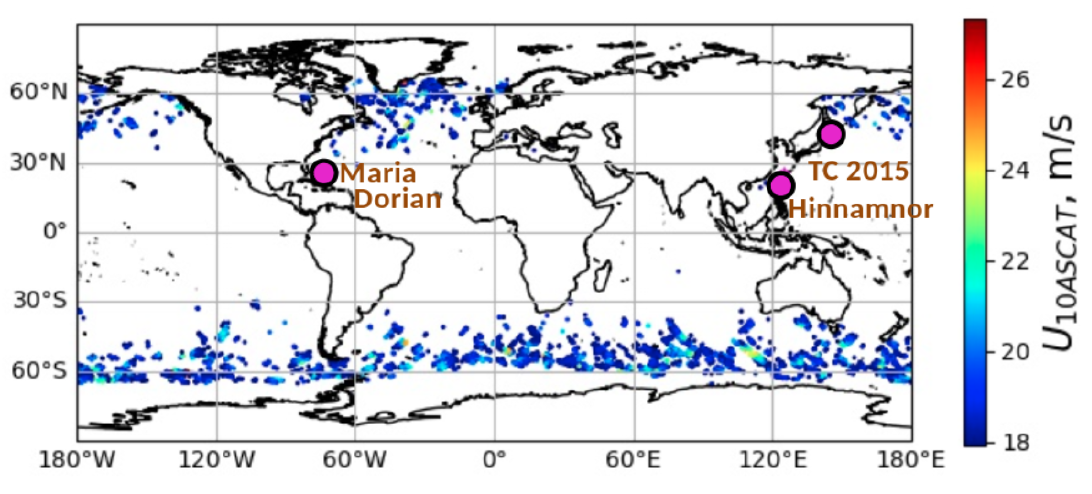
Figure 4. The locations of high wind speed areas in the collocated dataset and the position of tropical cyclones discussed in Section